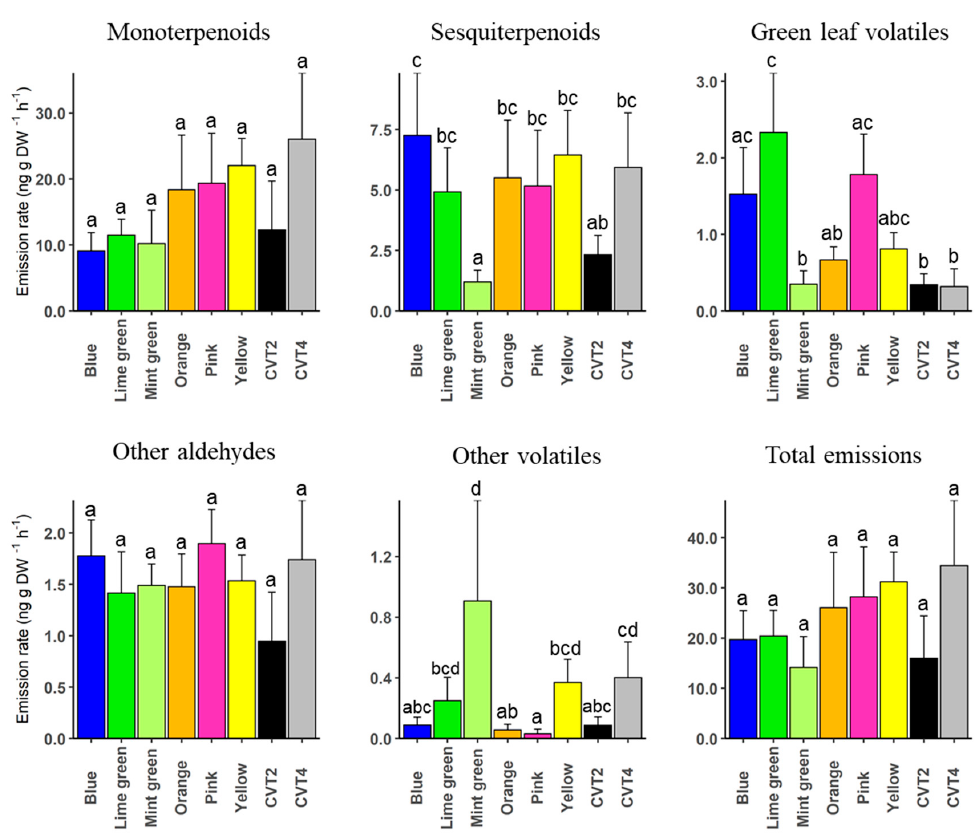
Figure 2. The proportion of major chemical classes from eight m¯anuka genotypes ( n = 5). A set of level contrasts was constructed using the “relevel” function in R. Bars show mean ± SE emissions, and different letters indicate significant differences between genotypes.